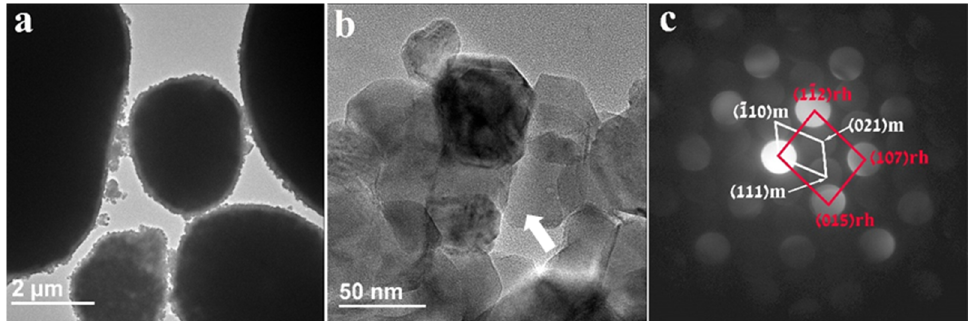
Figure 3. ( a ) TEM image of untreated HE-NCM displaying the typical ball-shaped “primary” particles of several micrometers in diameter; ( b ) 30–70 nm-sized “secondary” particles (grains); ( c ) CBED patterns taken from a 7 nm area from the particle marked by the white arrow. They represent the Li(TM)O 2 rhombohedral R-3m (166) and Li 2 MnO 3 monoclinic C2/m (12) phases, marked rh and m, respectively.